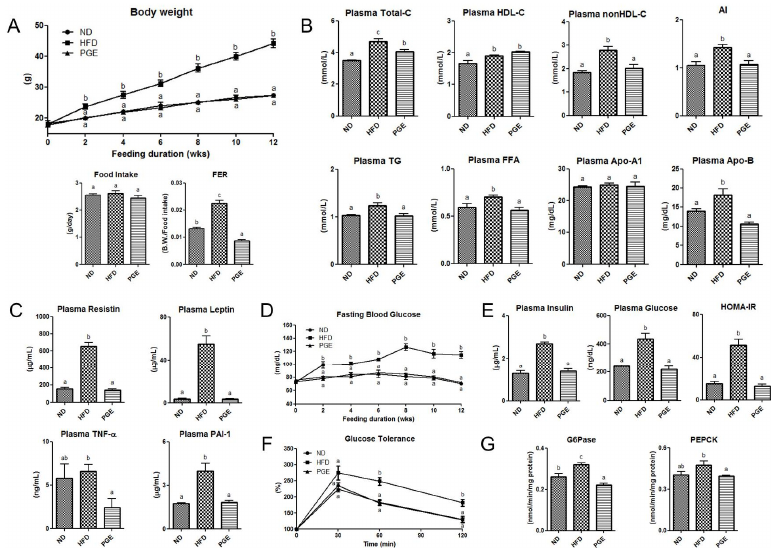
Figure 1. Effects of dietary PGE on body weight gain, plasma lipid profiles, insulin resistance, and glucose tolerance via modulating hepatic glucose ‐ regulating enzyme activities in HFD ‐ fed C57BL/6J mice. The data are the mean ± SEM ( n = 10). ( A ) Changes in the body weight, food intake, and food efficiency ratio (FER); ( B ) levels of plasma total, HDL, and non ‐ HDL cholesterol, AI, TG, FFA, Apo A ‐ 1, and Apo B; ( C ) levels of plasma resistin, leptin, TNF ‐α , and PAI ‐ 1; ( D ) blood glucose levels after 12 h of fasting; ( E ) plasma insulin and glucose levels after 12 h of fasting and the HOMA ‐ IR calculated using the fasting blood glucose and insulin levels; ( F ) glucose tolerance; and ( G ) activities of the glucose ‐ regulating enzymes G6Pase and PEPCK. ND, mice fed a normal diet; HFD, mice fed a high ‐ fat diet (HFD) alone; PGE, Platycodon grandiflorus root extract (5%, w / w ) ‐ treated HFD ‐ fed mice. B.W., body weight, AI, atherogenic index, ((Total ‐ C) ‐ (HDL ‐ C))/HDL ‐ C. PGE significantly suppressed the body weight gain from the first week of high ‐ fat feeding and decreased the food efficiency ratio, with no difference in food intake (Figure 1A). Interestingly, the addition of PGE led to a significant reduction of body weight compared to that in the HFD group,